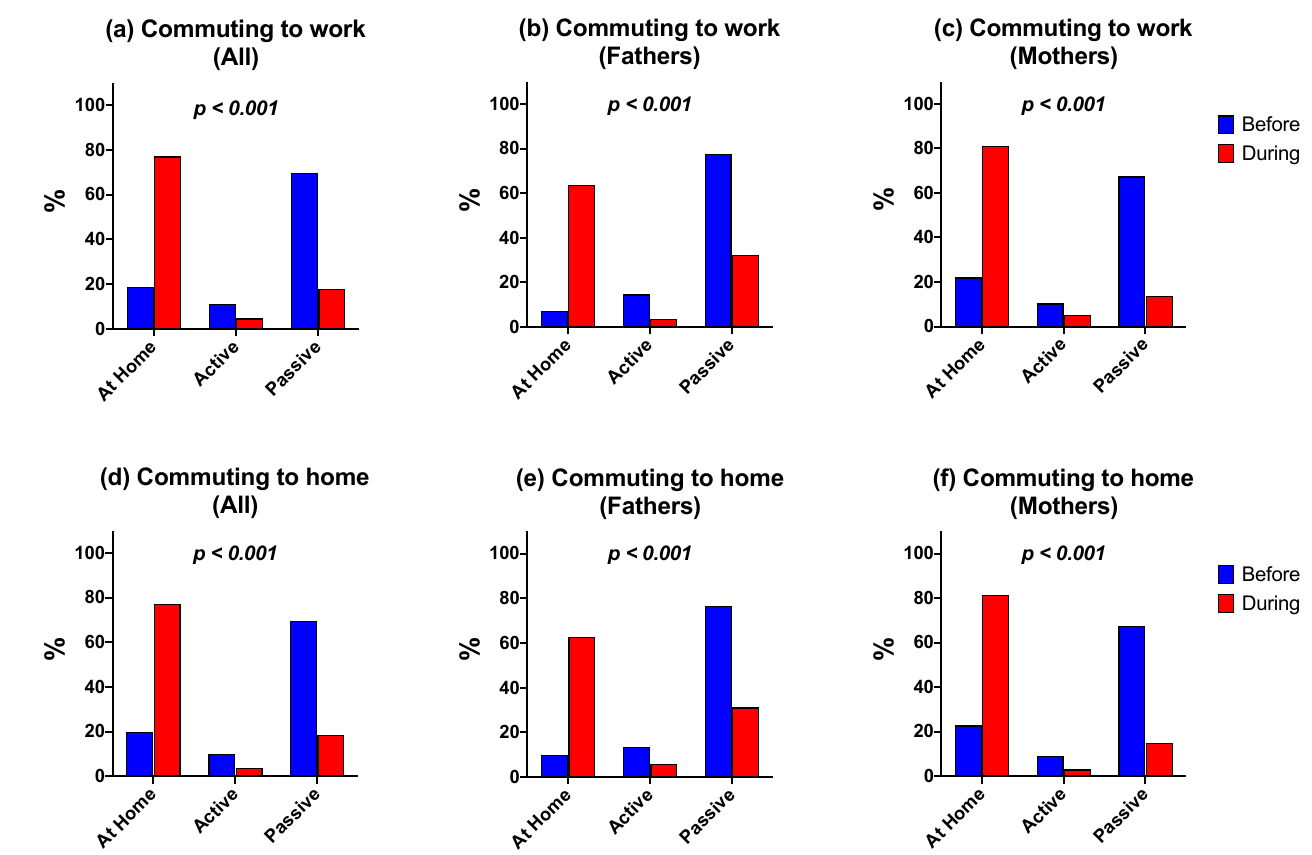
Figure 1. Prevalence of active commuting “to work” and “to home” before and during the COVID-19 pandemic according to mothers and fathers. ( a ) Active commuting to work before and during the pandemic in both sexes, ( b ) Active commuting to work before and during pandemic in fathers, ( c ) Active commuting to work before and during the pandemic in mothers, ( d ) Active commuting to home before and during the pandemic in both sexes, ( e ) Active commuting to home before and during pandemic in fathers, ( f ) Active commuting to home before and during the pandemic in moth- ers.